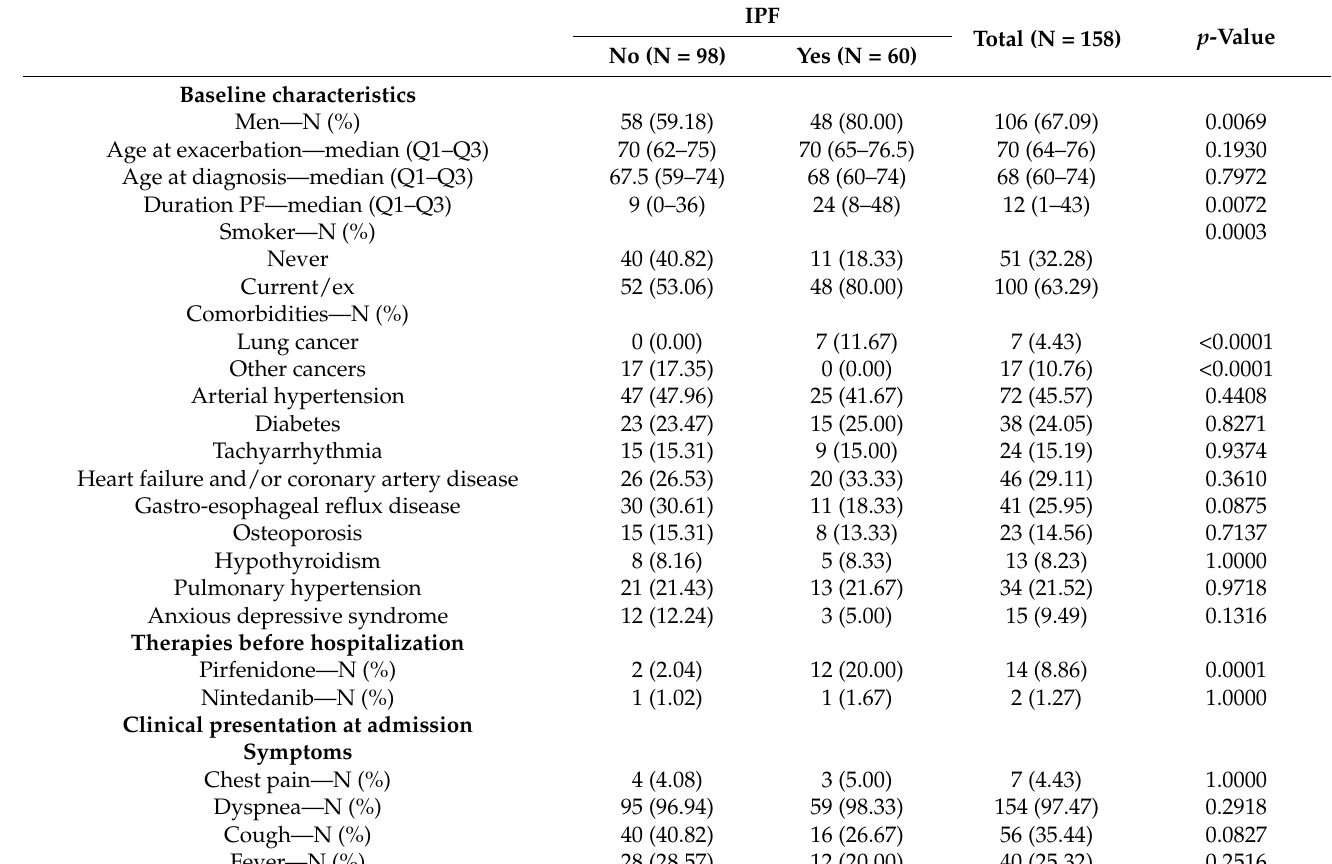
Table 1. Baseline characteristics, clinical presentation, and blood exams at hospital admission.